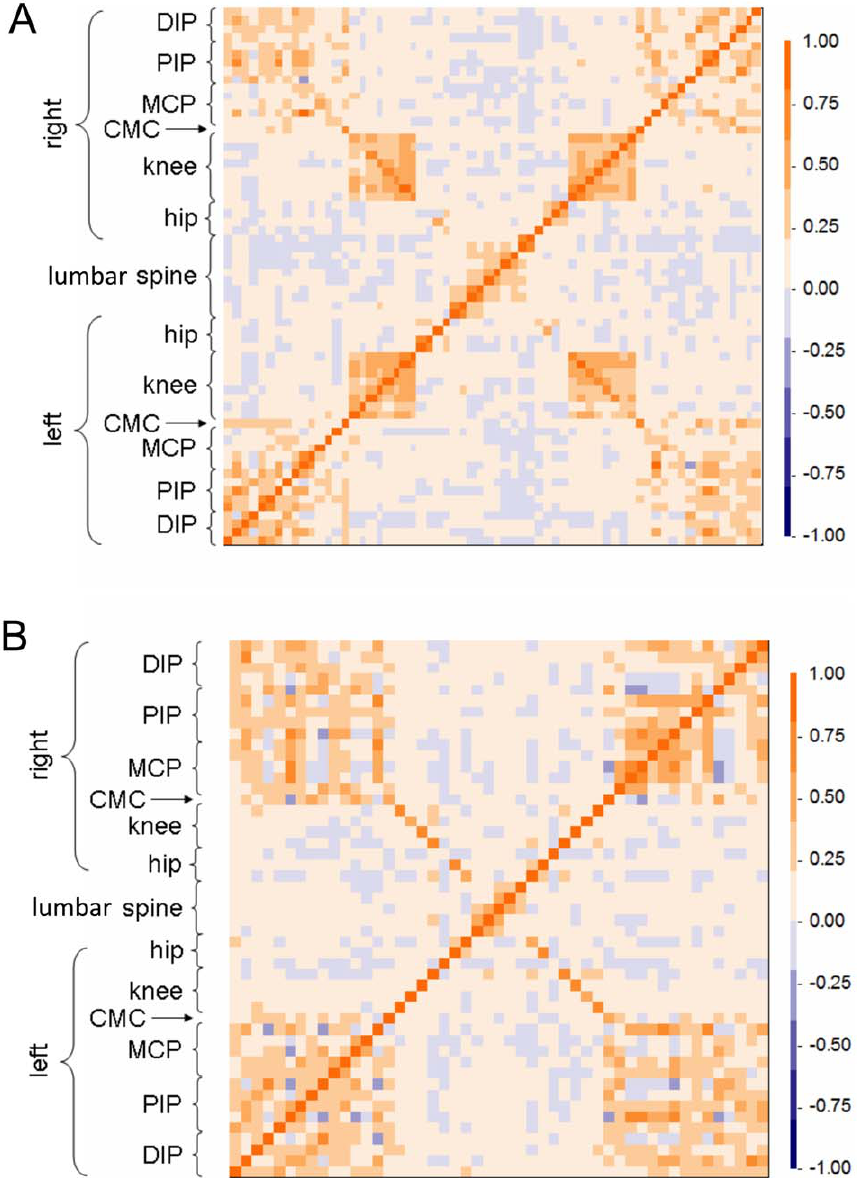
Figure 1. Correlation matrix of radiographic features of osteoarthritis. The correlation for left and right joints are shown for A) osteophyte score in each pair of joint faces, B) joint space narrowing score for each pair of faces. Each cell indicates the correlation between two joint faces as indicated in the color legend. The correlation matrix is symmetric by definition across the main diagonal. Left and right sides of the body are depicted from bottom to top on the y-axis and from left to right on the x-axis. n OST and n JSN (Figure 2), i.e. joint faces were counted without